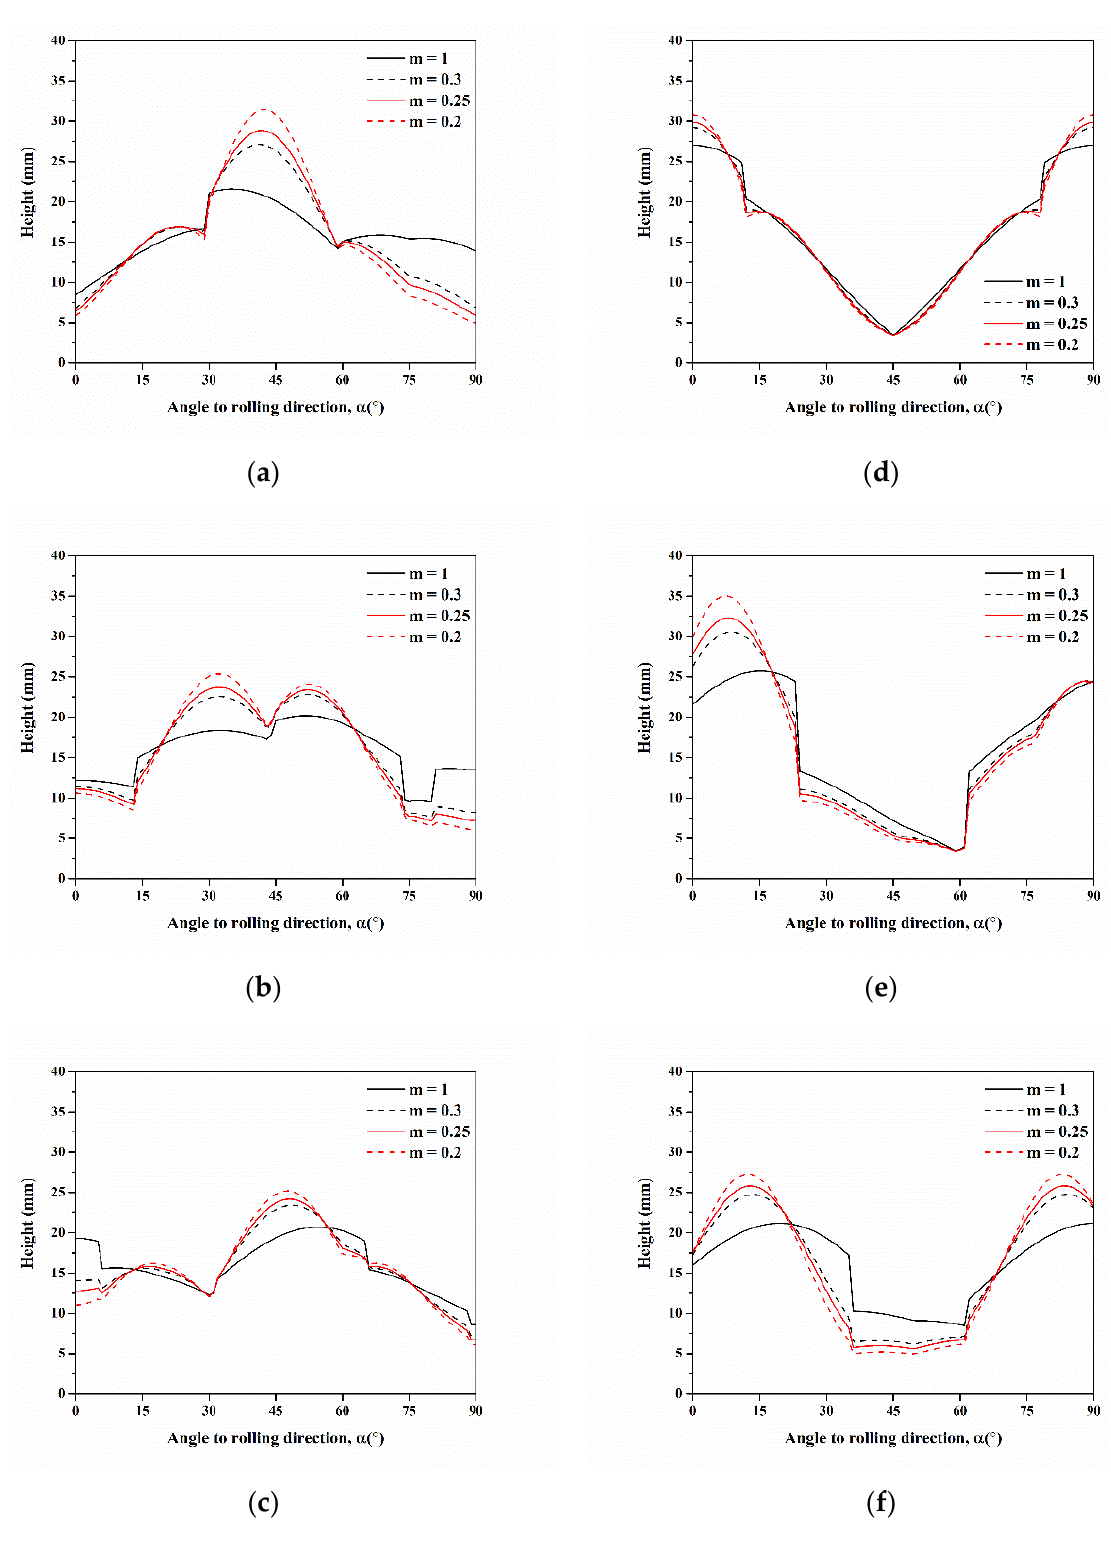
Figure 11. Cup height profiles as a function of the angle for texture components of ( a ) C, ( b ) S, ( c ) B, ( d ) Cube, ( e ) r-Cube, and ( f ) G predicted by assuming hardening exponent m from 0.2 to 1 and stress ratio q = − 0.3.